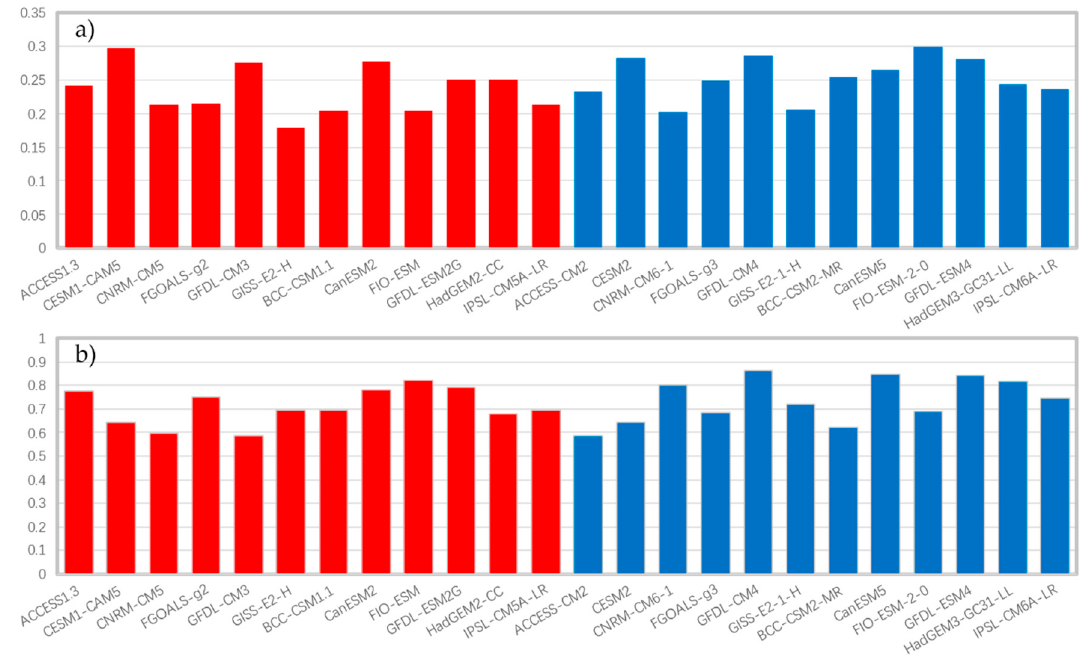
Figure 2. Skill scores of the 12 CMIP5 models ( blue ) and 12 CMIP6 models ( orange ) for ( a ) SLP and ( b ) SST, respectively.